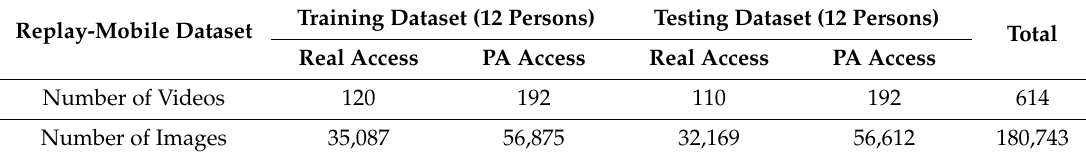
Table 5. Description of the original Replay-mobile dataset used in our